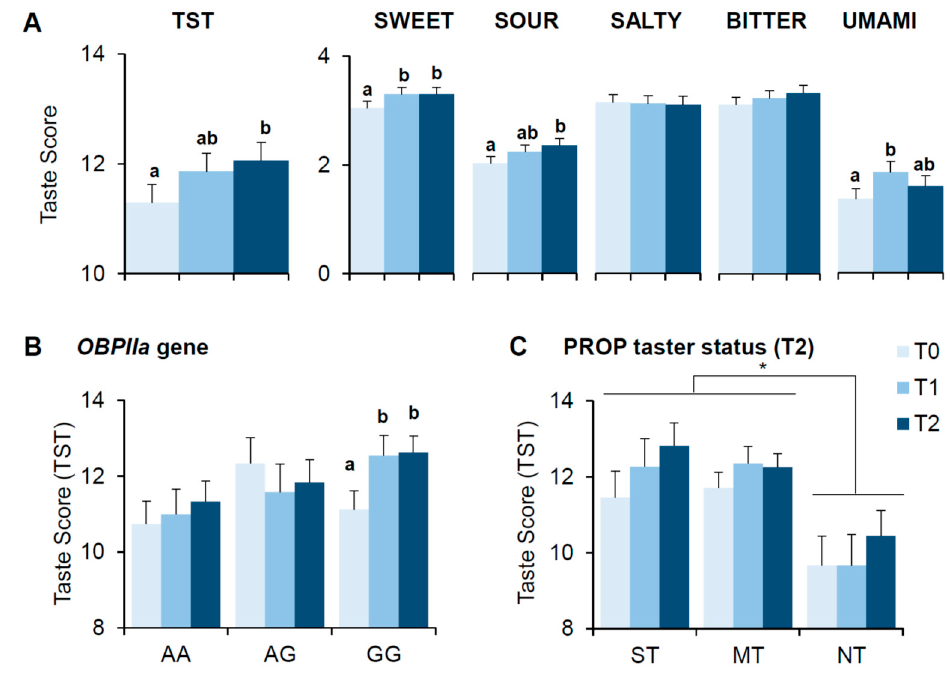
Figure 2. Taste perception scores determined before (T0), one month (T1) and six months (T2) after bariatric surgery. Means (±SEM) values of the total taste score of the whole Taste Strip Test (TST) and of that relative to sweet, sour, salty, bitter and umami ( n = 51) ( A ). Data of the total taste score of the whole TST are shown according to the rs2590498 polymorphism of OBPIIa gene (genotypes AA: n = 15; genotypes AG: n = 12; genotypes GG: n = 24) ( B ) or PROP taster status determined at T2 (super-tasters: n = 11; medium tasters: n = 31; non-tasters: n = 9) ( C ). Different letters indicate a significant difference ( p ≤ 0.048, Fisher’s test LSD subsequent repeated measures ANOVA). * indicate a significant difference between values of tasters and non-tasters (p ≤ 0.027 Fisher’s test LSD subsequent repeated measures ANOVA).